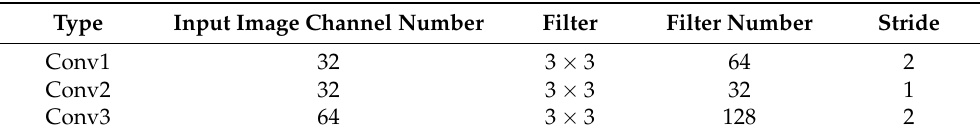
Figure 3. The overall structure of the second stage. Each stage is composed of a residual module, a feature fusion module, and a conversion module. Table 1. The parameters in the network of the second stage. Conv means a convolution operation, and “Conv1”, “Conv2”, and “Conv3” correspond to Figure 3’s “Conv1”, “Conv2”, and “Conv3”, respectively.